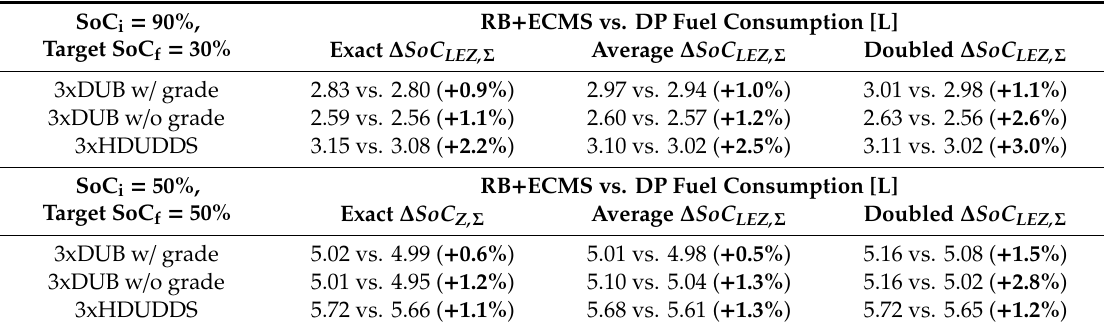
Table 1. Fuel consumption values corresponding to simulation results from Figure 15 and their relative di ff erences in comparison with DP benchmark (given in